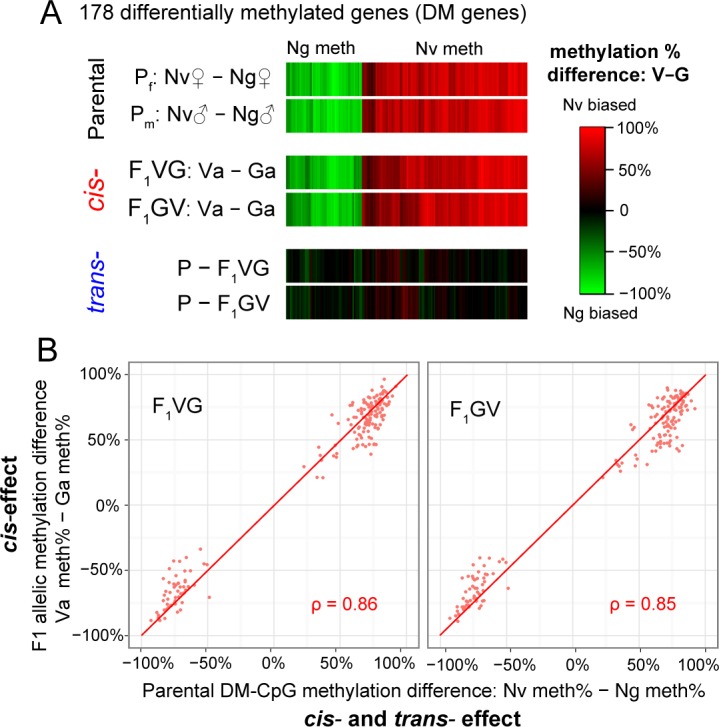
Differentially methylated genes between N. vitripennis and N. giraulti retain their parental methylation status into F1 adults.(A) Heat map showing that the 178 differentially methylated (DM) genes between N. vitripennis (Nv) and N. giraulti (Ng) also display strong allele-specific cis- regulation in both reciprocal F1 crosses (red: methylated in Nv; green: methylated in Ng). The top panel shows the parental methylation divergence for DM genes in females and males, quantified by Nv minus Ng methylation percentage in two sexes. The middle panel shows the cis-effect of DNA methylation in both reciprocal F1s, quantified by V allele (Va) methylation percentage minus the G allele (Ga) methylation percentage in F1VG and F1GV, respectively. Plotted in the bottom panel is the trans-effect, calculated as the total parental methylation divergence minus the cis-effect. The parental DNA methylation difference for DM genes could be explained by the cis-effect alone, with close to zero trans-effect in both reciprocal crosses. (B) Plotted on the x-axis are the parental methylation divergences averaged across differentially methylated CpGs (DM-CpGs) for each DM gene, measured by Nv minus Ng methylation percentage. On the y-axis are the F1 allelic methylation differences in F1VG (left panel) and F1GV (right panel), measured by vitripennis allele (Va) methylation percentage minus giraulti allele (Ga) methylation percentage in F1s. Spearman's rank correlation coefficients (ρ) are in the bottom right corner. Data presented in this figure can be found at http://dx.doi.org/10.5061/dryad.qf2t8.